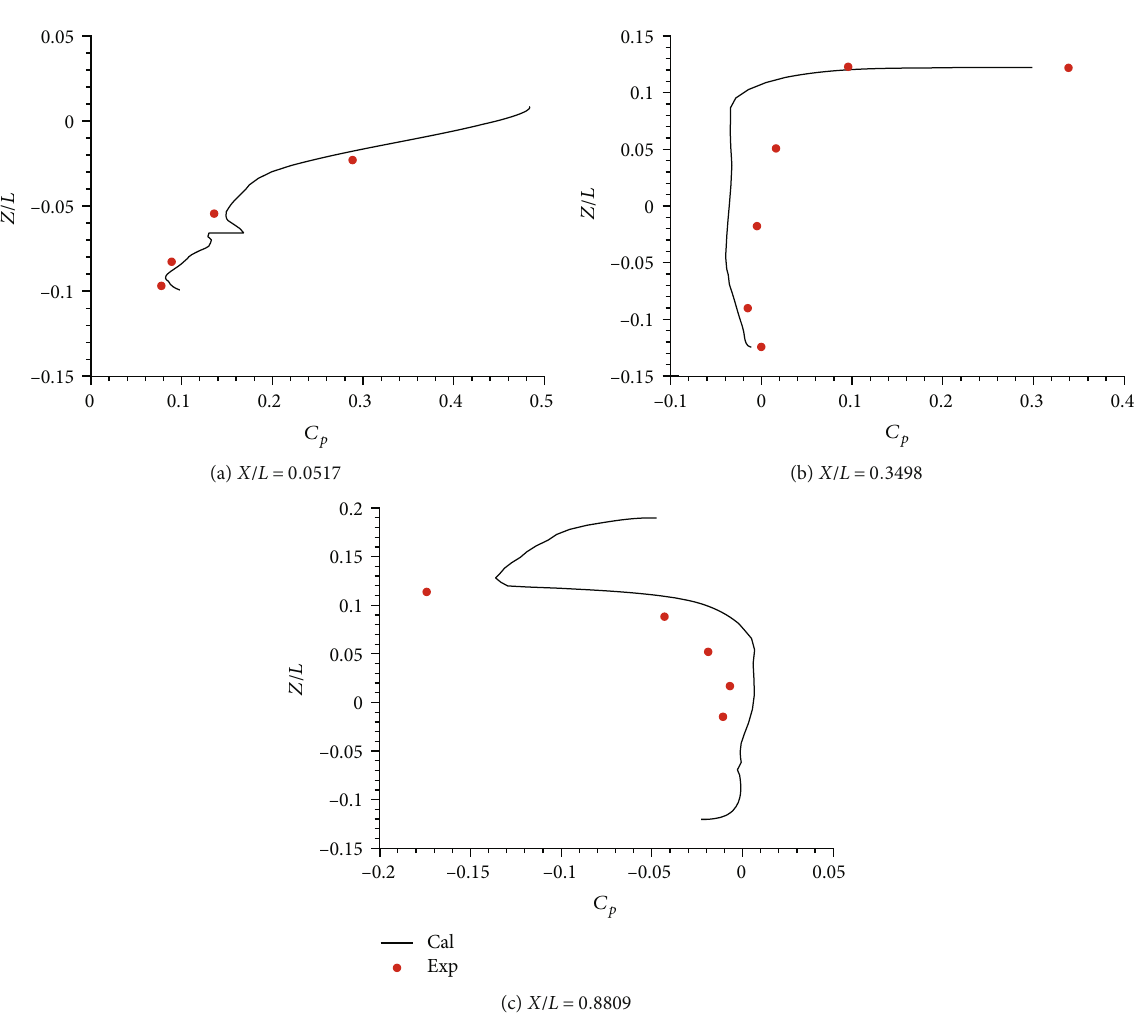
Figure 13: Computed and experimental pressure distributions across ROBIN fuselage section.